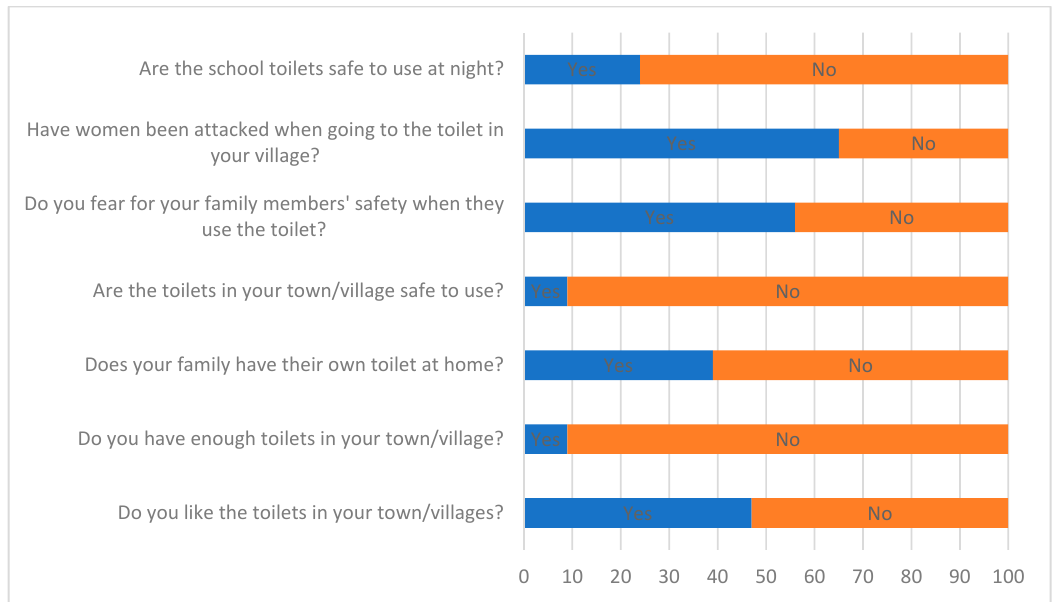
Figure 5. Pre-installation questions and answers.